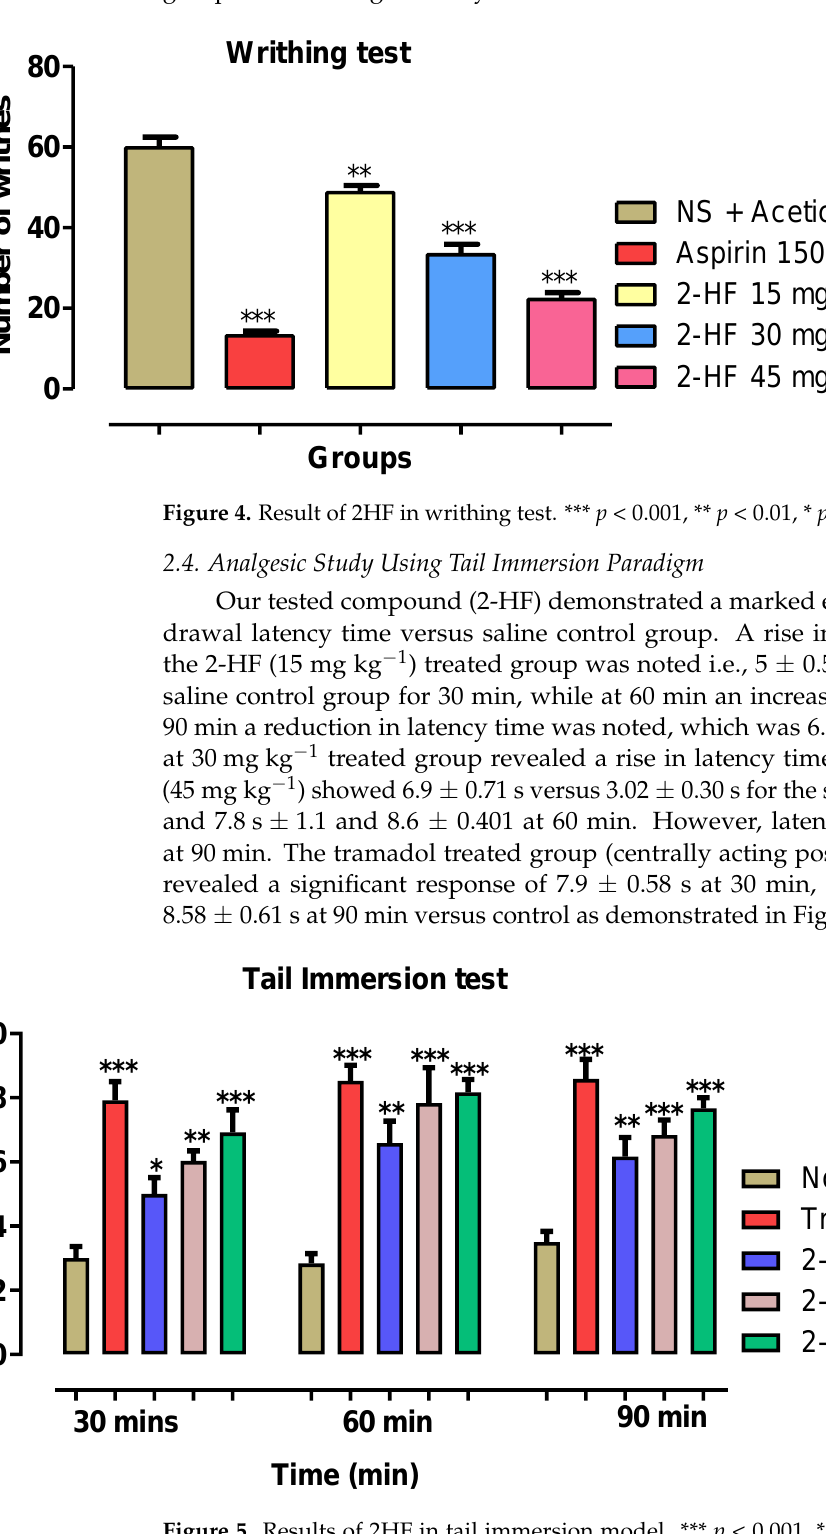
Figure 5. Results of 2HF in tail immersion model. *** p < 0.001, ** p < 0.01, * p < 0.05 vs. control, two-way repeated measures ANOVA followed by Tukey’s post hoc test.